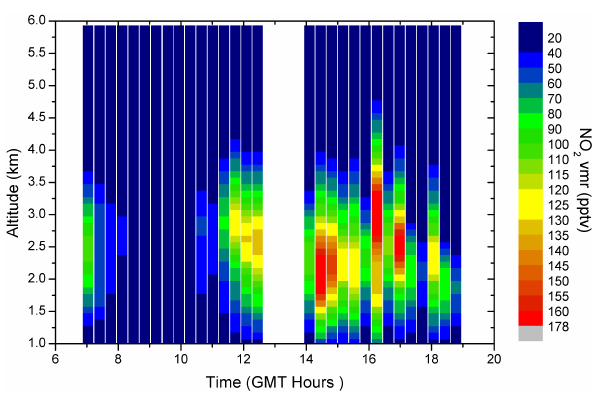
Figure 4. Unsmoothed vertical profiles of NO 2 vmr (in ppbv) for day 128/2013 obtained by the OEM technique. Each vertical col- umn represents an individual scanning cycle (for details, see text).